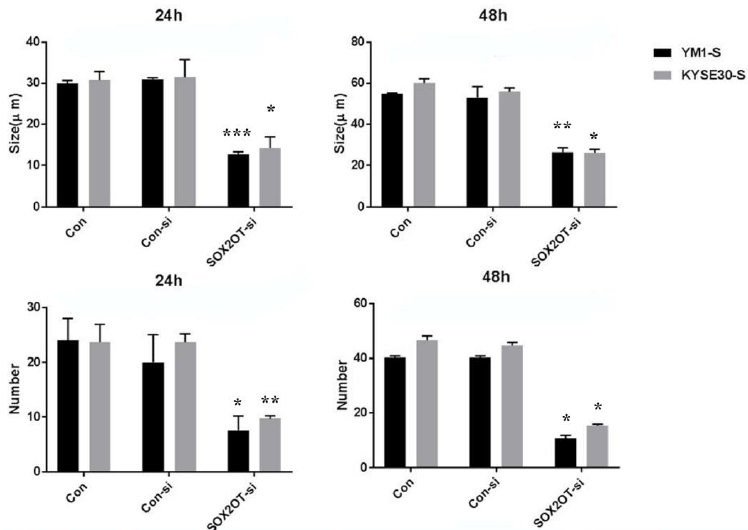
Figure 6. The sphere formation capability of ESCC tumorspheres after SOX2OT knockdown. The comparison was carried out between SOX2OT knocked down (SOX2OT-si) and control siRNA transfected (Con-si) tumorspheres of each cell line. Both sphere diameter and count were measured in at least five fields with light microscopy for 24 and 48 h after transfection. * p -value ≤ 0.05 and ** p -value < 0.003 and *** p -value = 0.0001 vs. control.